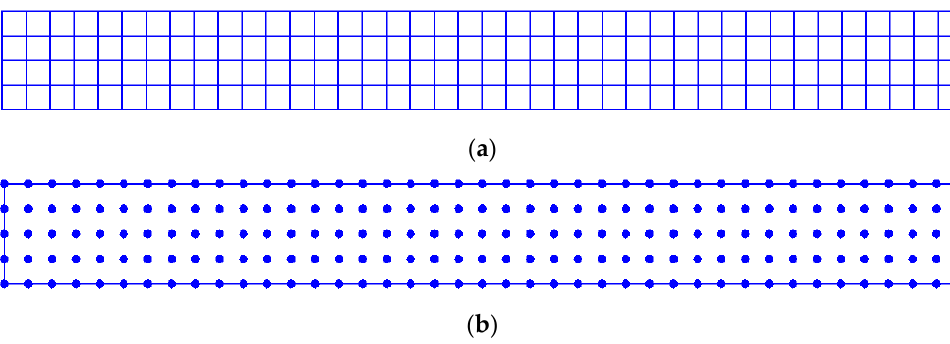
Figure 3. The different node arrangement patterns that are employed to discretize the cantilever beam for different numerical methods: ( a ) uniform mesh pattern, which is used to discretize the cantilever beam for the standard FEM-Q4; ( b ) node arrangement pattern used to discretize the cantilever beam for the RPIM and M-RPIM.